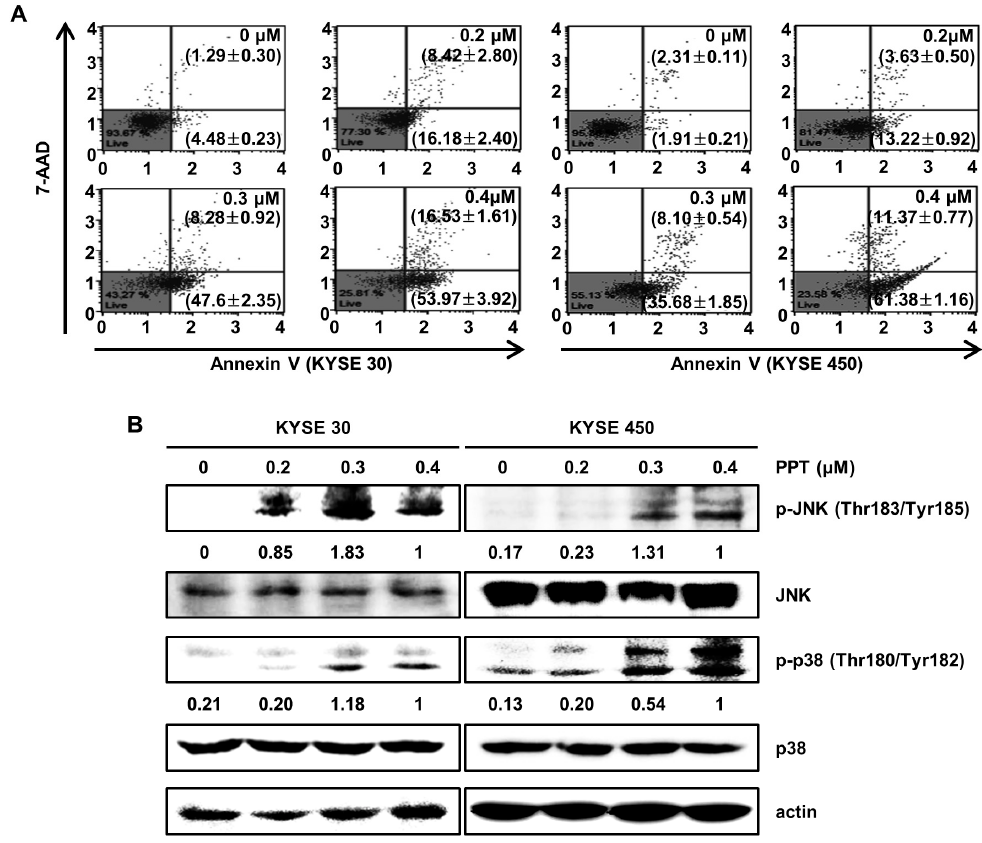
Figure 3. PPT induces cell apoptosis in a dose-dependent manner through the c-Jun N-terminal kinase (JNK)/p38 signaling pathways. KYSE 30 and KYSE 450 cells were treated with different concentrations of PPT (0.2, 0.3, and 0.4 µM) or DMSO for 48 h. ( A ) The cells were double-stained with annexin V/7-aminoactinomycin D (7-AAD). The apoptotic effects of PPT were assessed using a Muse™ Cell Analyzer (Merck Millipore) in the ESCC cell lines compared to the DMSO-treated control group. ( B ) The level of apoptosis-related protein phosphor (p)-JNK and p-p38 in the ESCC cells was detected by Western blot assays with actin as a loading control.